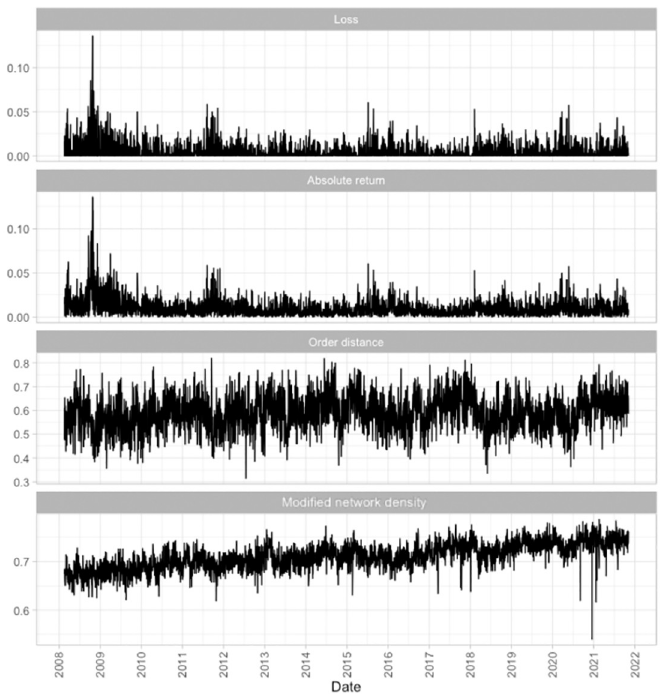
Fig 8. The time series of the responses (loss and absolute return) and the independent variables (order distance and modified network density) from 2008 to 2021.